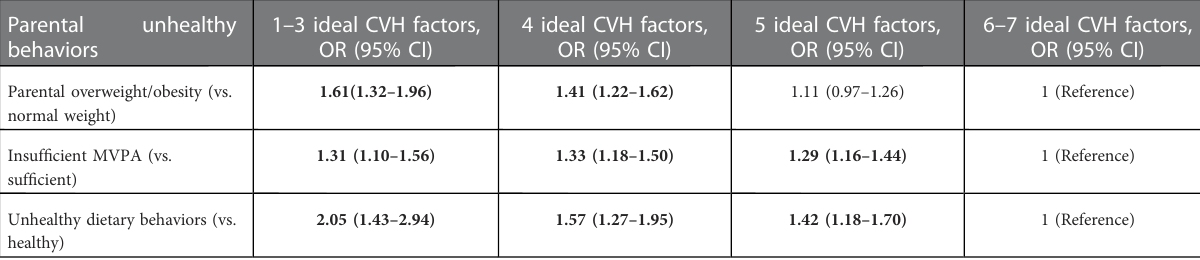
Unhealthy dietary behaviors (vs.